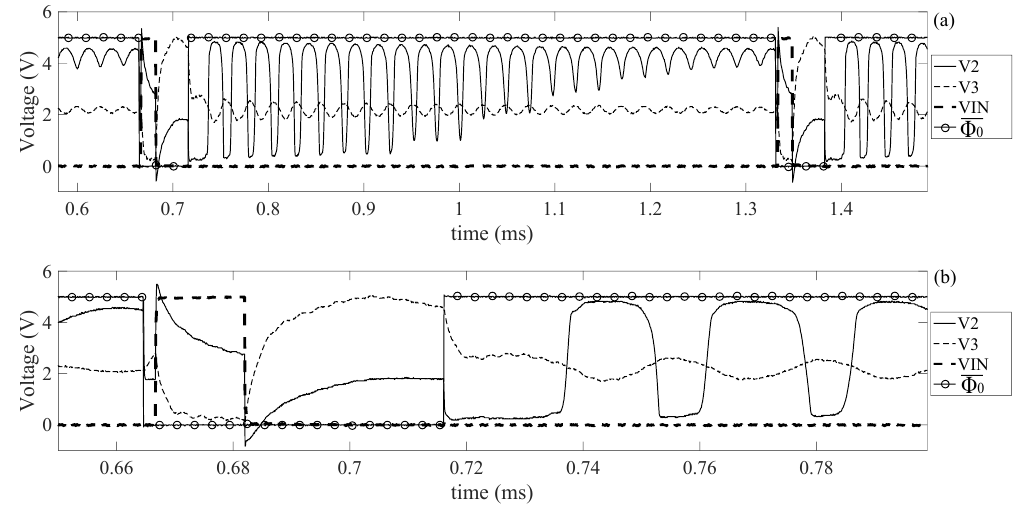
Figure 25. Whole read-out cycle driving a real piezoelectric sensor. ( a ) analysis of the main signals in a whole cycle; ( b ) analysis of the main signals in actuation